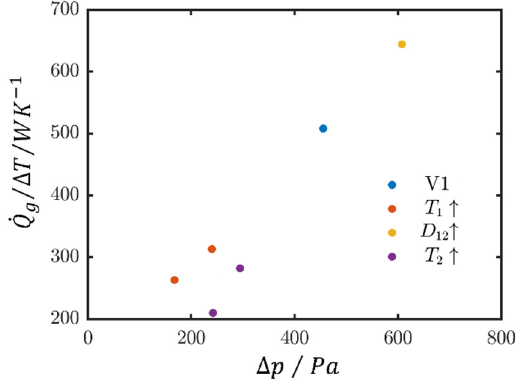
(cid:16) (cid:17) v g = 7.0 m/s .